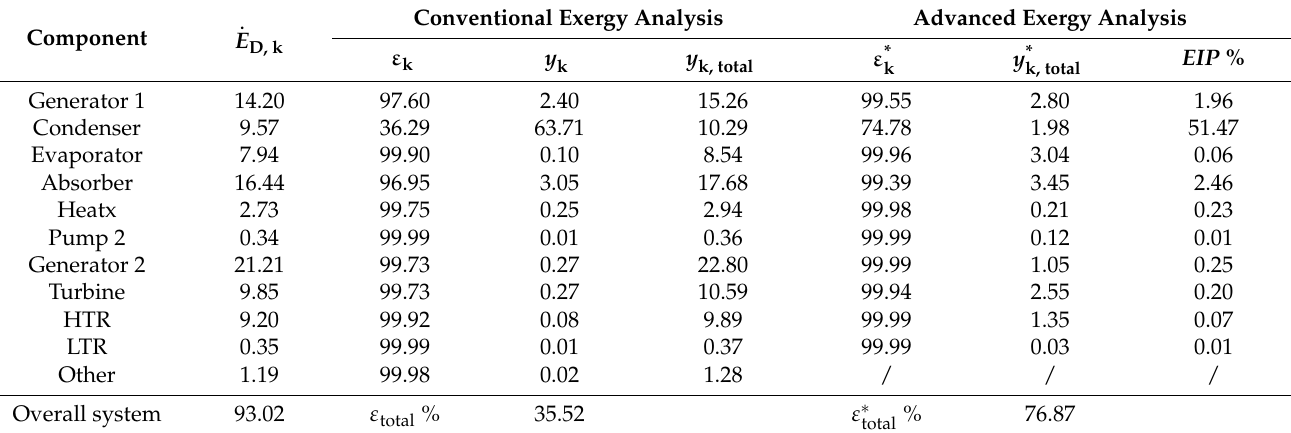
Table 7. Exergy efficiency, exergy destruction ratio and EIP